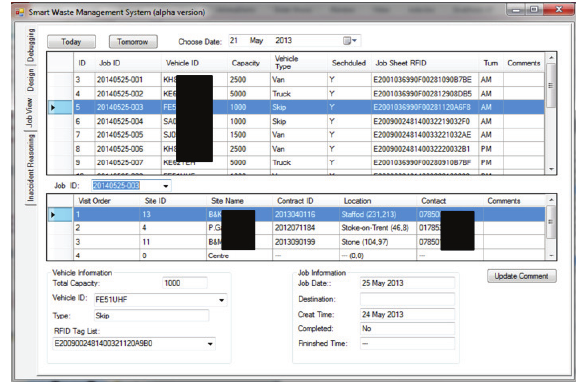
Fig. 12. Example of Scheduling